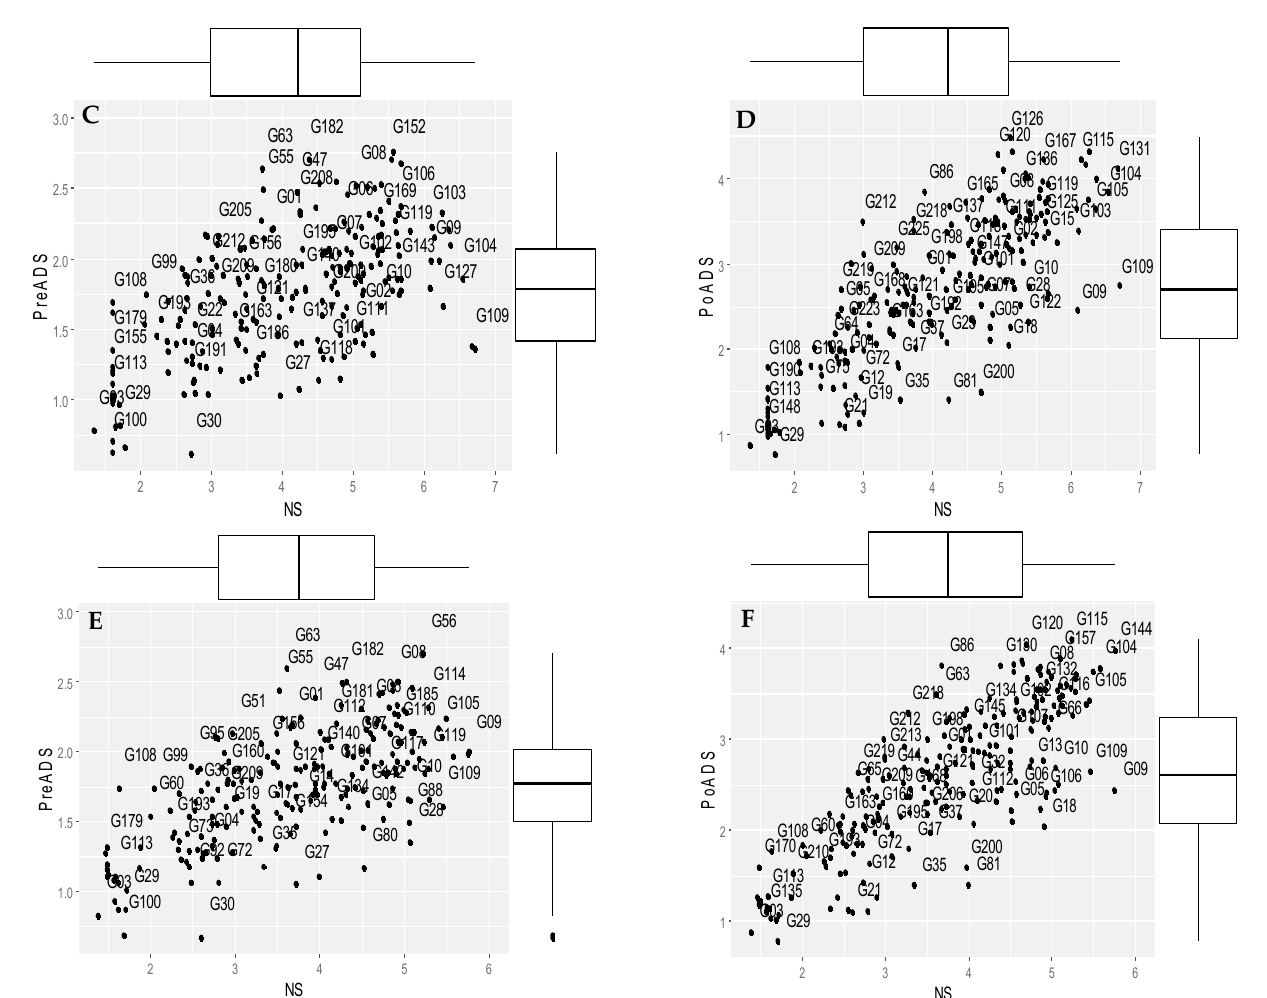
Figure 1. Scheme showing grouping of 225 sorghum genotypes for mean grain yield (t/ha) when evaluated under non-stressed (NS), pre-anthesis drought-stress (PreADS), and post-anthesis drought-stress (PoADS) conditions in the greenhouse ( A , B ) and field ( C , D ) environments, and across both glasshouse and field ( E , F ) environments. The box plots summarise the five data summaries (minimum, first quartile, median, third quartile, and maximum) of grain yields under NS, PreADs, and PoADS conditions.